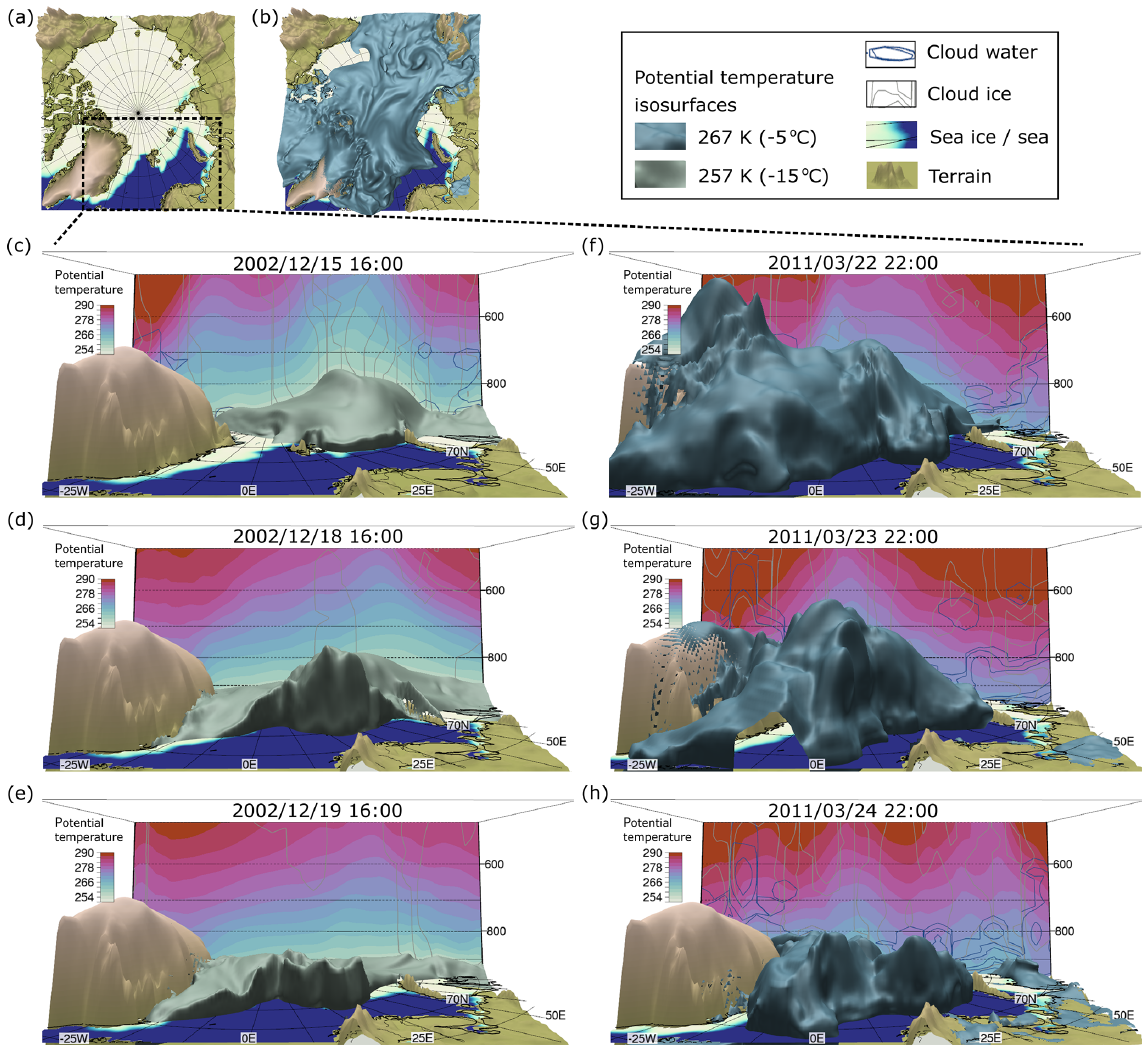
Figure 1. Three-dimensional interactive visual analysis of MCAOs in ERA5 data. Cold air is delineated by isosurfaces of potential tempera- ture. The air below the isosurfaces has lower potential temperatures, and the air above has higher potential temperatures. Panels (a, b) show a top view for locating the geographical domain of interest (Barents and Nordic seas). Temporal snapshots illustrate the transport of cold air during two MCAOs: (c–e) case 1, 15–19 December 2002 (257K isentrope); (f–h) case 2, 22–24 March 2011 (267K isentrope). Contour lines of cloud water and cloud ice are drawn at [10 − 5 , 10 − 6 , 10 − 8 ]kgkg − 1 . Movie 1 demonstrates the interactive 3-D data exploration of MCAO case 1 using Met.3D. Figure 2 illustrates winds during the PLs that formed within the MCAO depicted in panels (c–e)